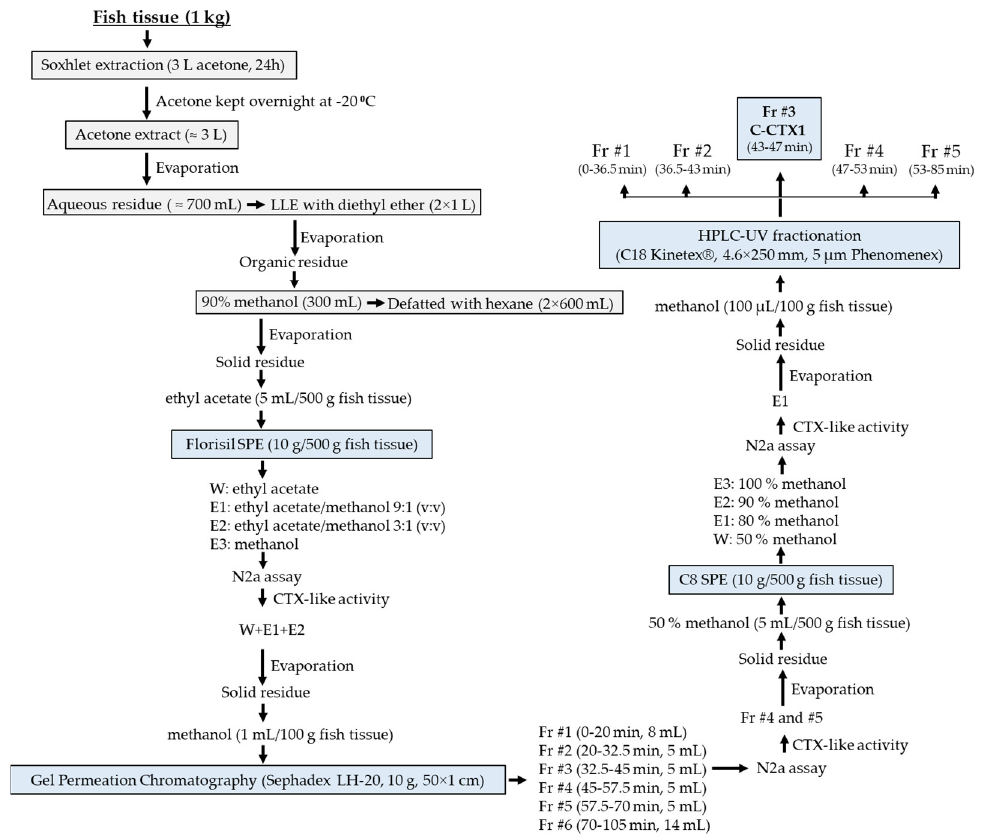
Figure 1. Scheme of the preparation of reference materials for C-CTX1 based on unpublished work by R. W. Dickey (1994).